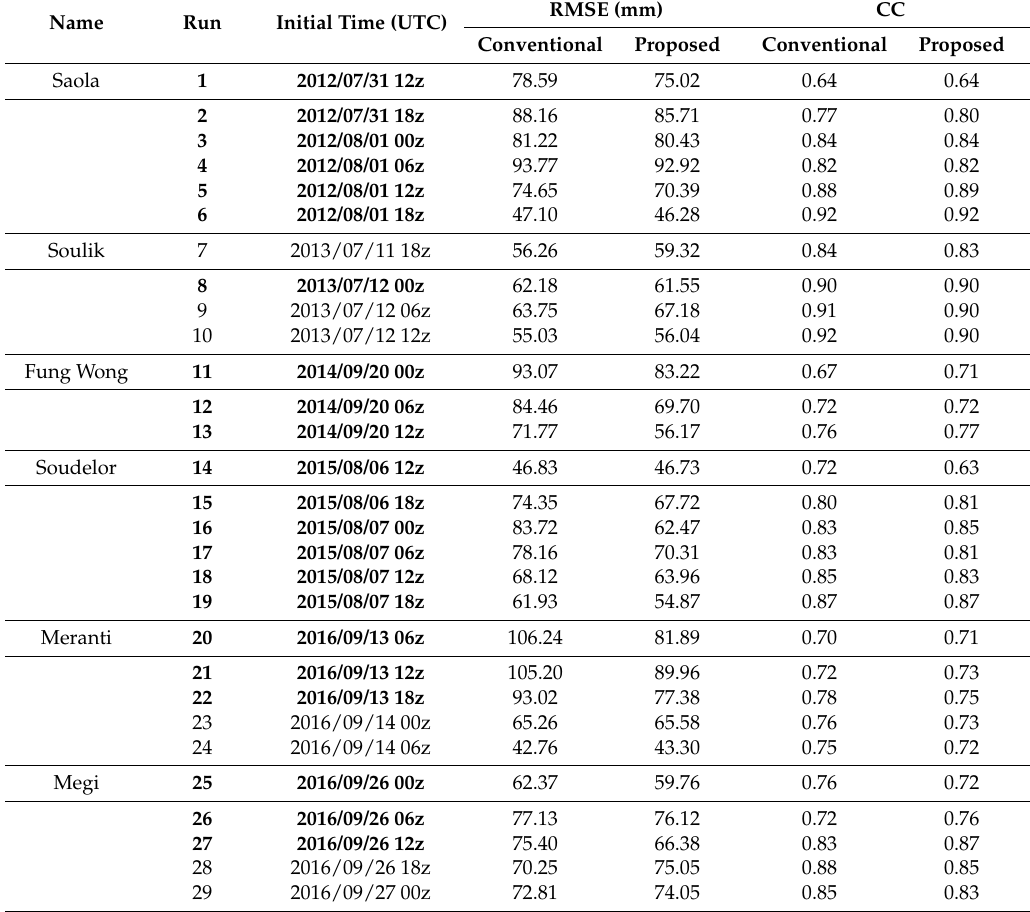
Table 2. CC and RMSE of the conventional and the proposed methodologies for 6